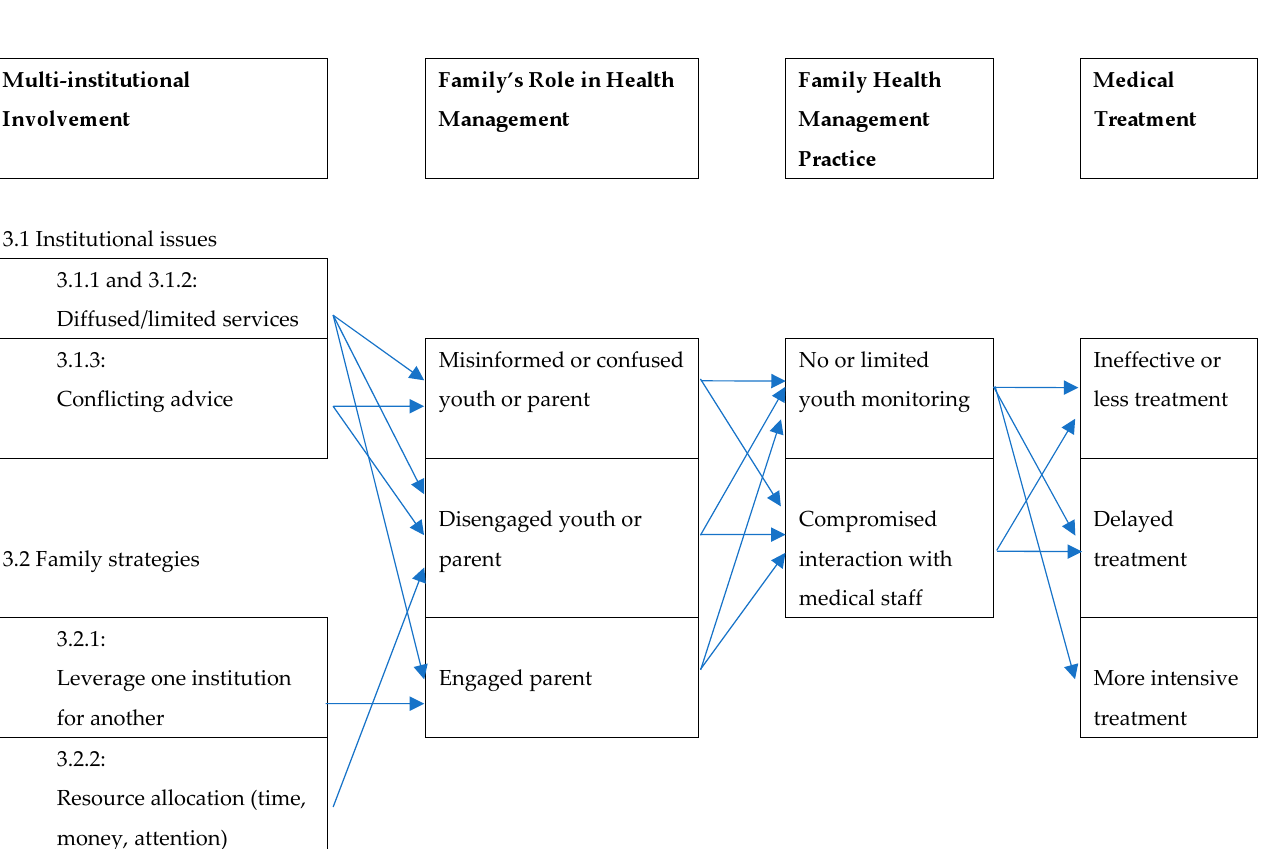
Figure 3. Pathways of multi-institutional involvement’s influence on youths’ medical treatment.